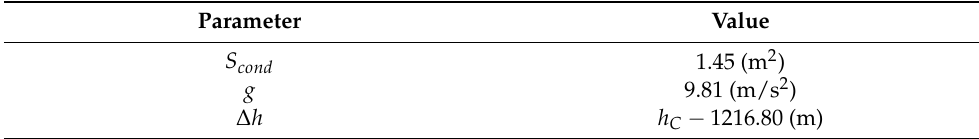
Table 1. Parameters for the application of the Torricelli law to the regulation gate’s flow rate.